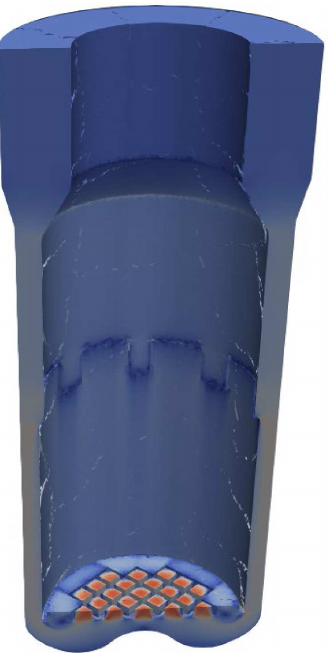
Fig. 10. TrioCFD model of the downcomer and lower plenum of NuSCALE developed in [36].